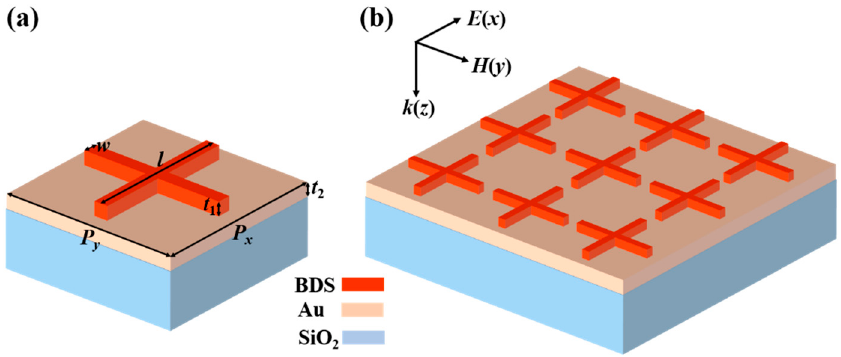
Figure 1. ( a ) Perspective view showing the relevant structural parameters. ( b ) The absorber with the upper layer of BDS and the underlying layer of Au rested on the SiO 2 substrate. The polarization direction of the incident wave is along the x -axis.